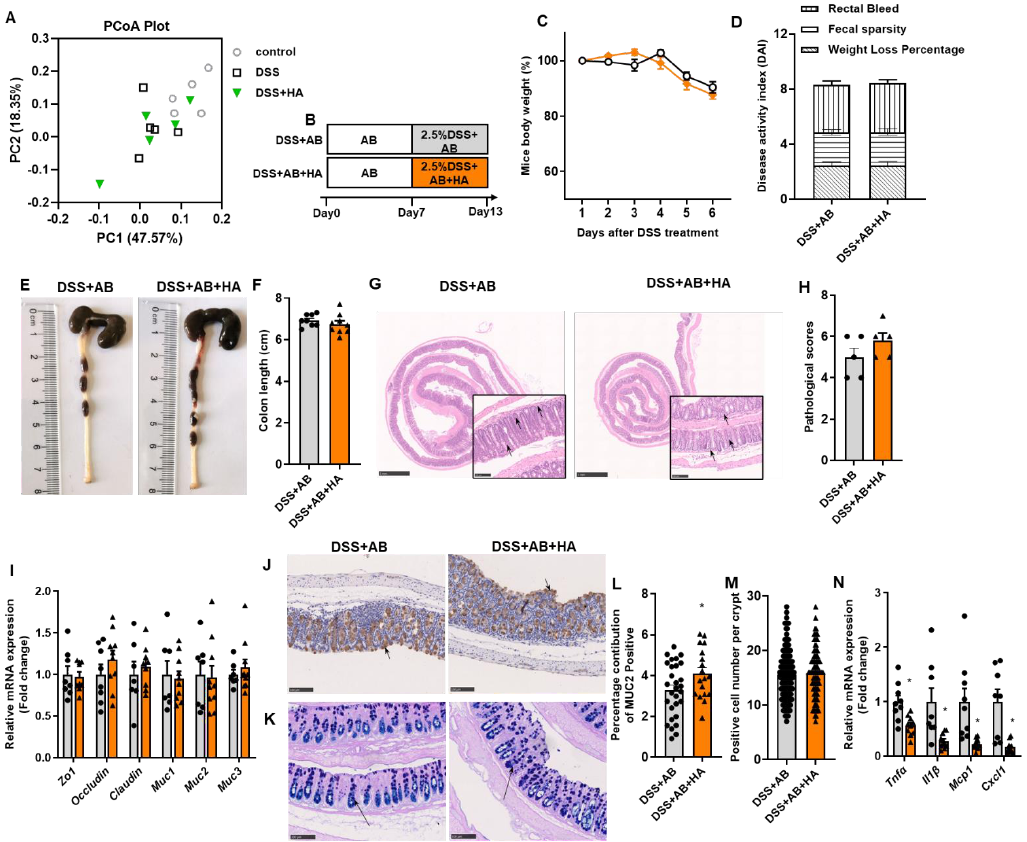
Figure 3. Antibiotics treatment blunts the effects of HA. ( A ) The β -diversity analysis of GM by prin- cipal component analysis (PCA) plot of Control, DSS, and DSS + HA ( n = 4 – 5). ( B ) Experimental design of antibiotics (AB) treatment. ( C ) Percentage change in body weight after DSS treatment. ( D ) Disease activity index (DAI) on day 7. ( E , F ) Representative image and length of the colon. ( G and H ) Representative image of H&E staining of colon and pathological score. The small panels (20×) were enlarged from the large panels (2.5×). ( I ) Relative mRNA expression of tight junction genes and mucin genes in the colon. ( J , L ) Immunohistochemical analysis of MUC2 in the colon (20×). ( K , M ) PAS-AB staining of the colon (20×). ( N ) Relative mRNA expression of inflammatory factors in the colon. Data are expressed as mean ± SE, n = 8 – 10, * p < 0.05.